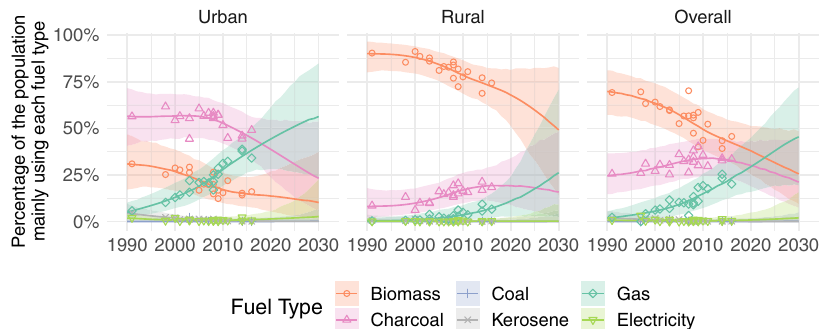
Fig. 8 Cooking fuel use in Ghana. Estimated (posterior median) percentage of the urban population (left), the rural population (center) and overall population (right) of Ghana mainly using each fuel type, with central estimates as lines. Points show available survey data. The 95% uncertainty intervals shown as shaded areas combine model uncertainty and survey variability: where data are plentiful, the uncertainty is small and the intervals capture the vast majority of survey points, where survey data are limited or unavailable, in particular when projecting into the future, the uncertainty grows, and our uncertainty intervals are wider. Plots for other LMICs are included in the Supplementary